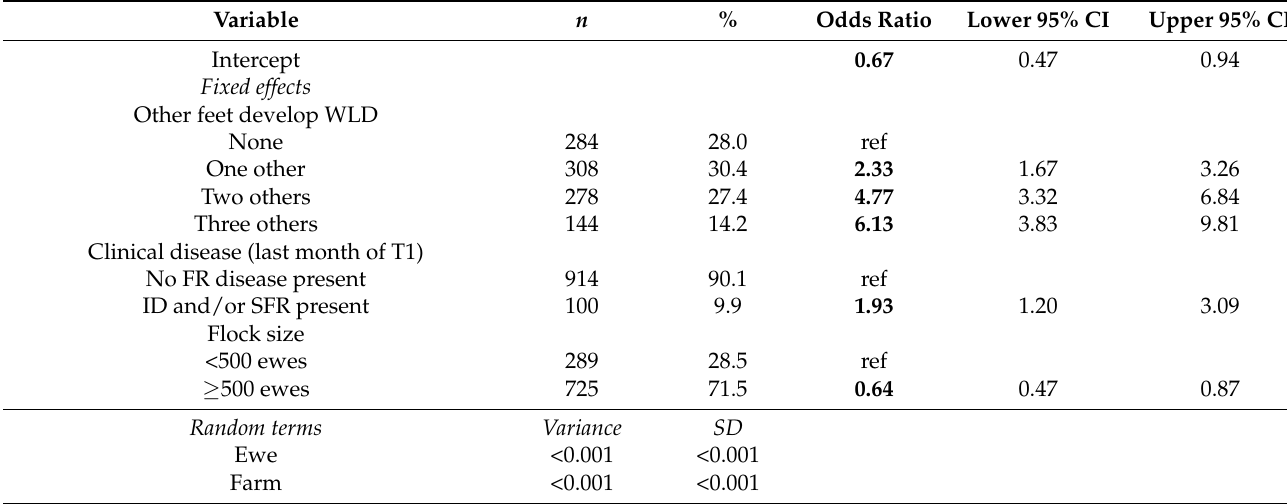
Table 11. Final multivariable model of the associations with the development of WLD at foot-level for 1014 observations of 351 ewes during transition period 1 (September 2019–January 2020).